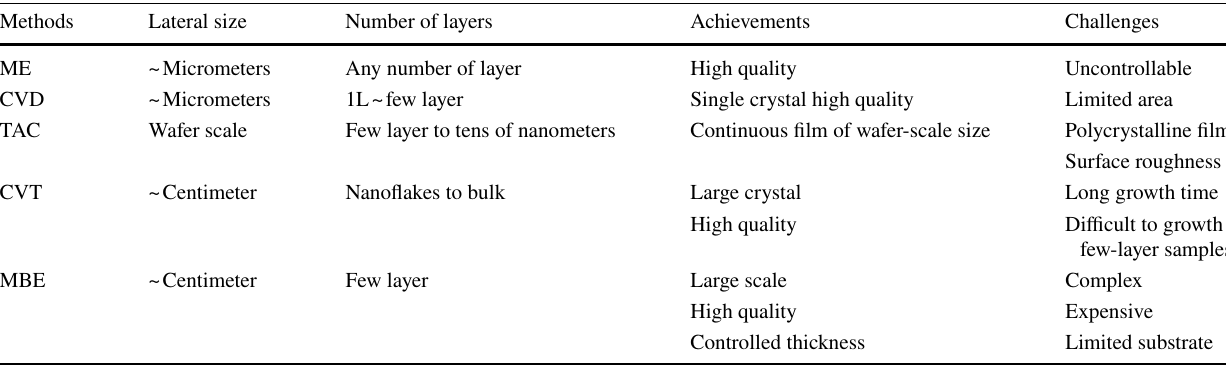
Table 1 Comparison of different synthesis methods to prepare 2D PtSe 2